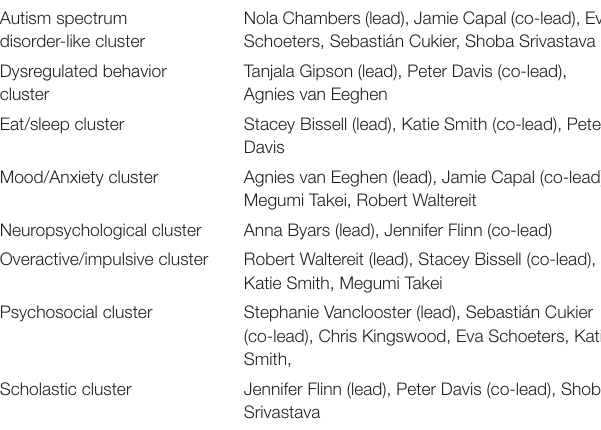
TABLE 2 | Cluster groups and